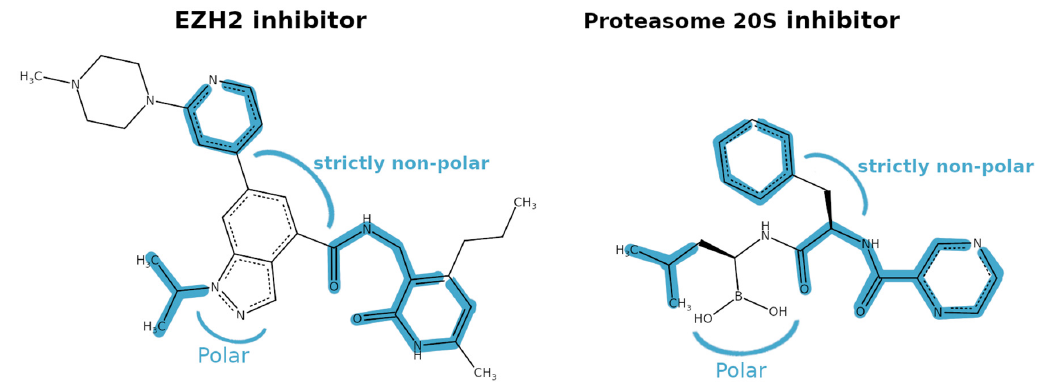
Figure 7. Hypothesis for 2D similarities between EZH2 and P20S X-ray ligands (GSK343 and bortezomib, respectively), shown from left to right, where the blue regions highlight equivalent or very similar regions of both molecules.